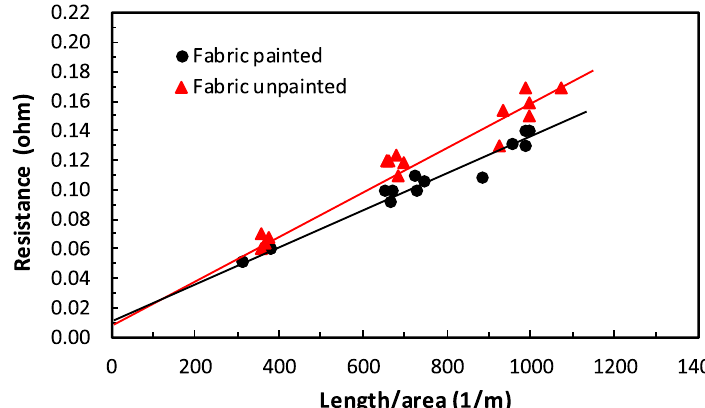
Fig. 6 Electrical contact resistance at interfaces in in-plane direction of carbon/epoxy